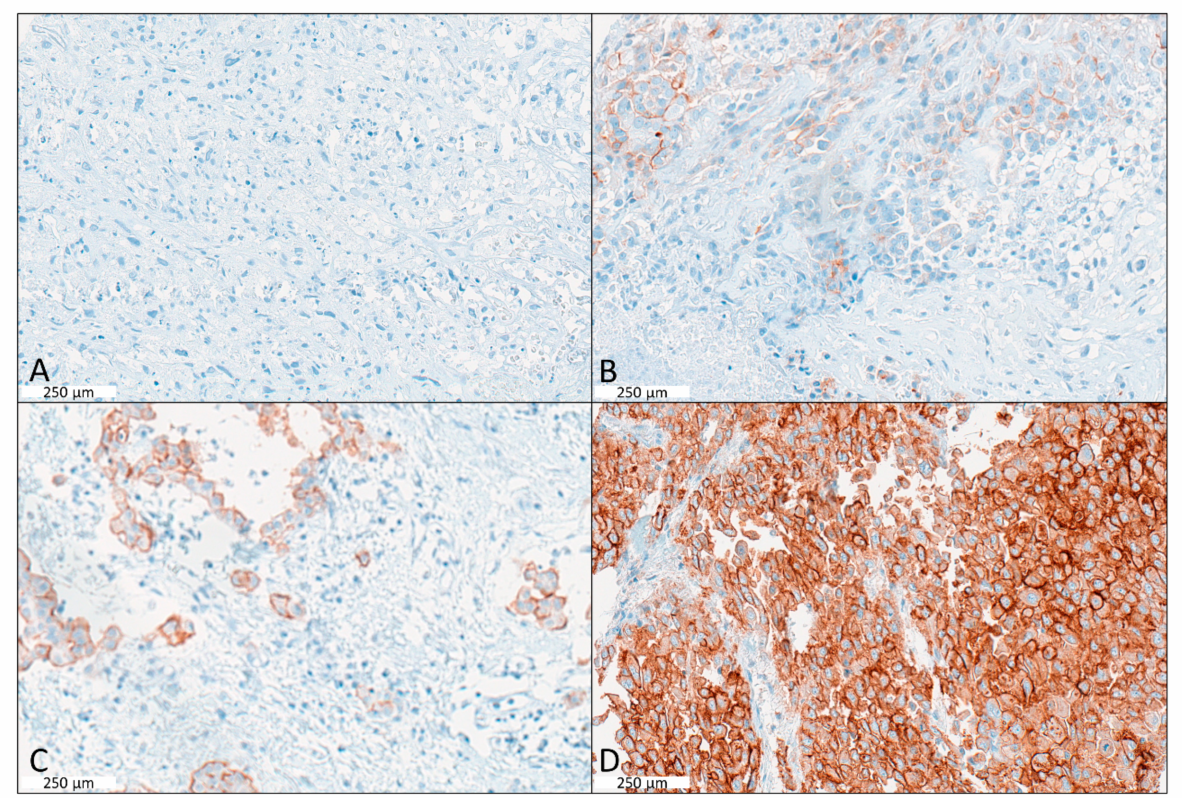
Figure 2. Examples of Immunohistochemically MSLN staining scores. ( A ) IHC of sarcomatoid MPM being negative for MSLN (Score 0). ( B ) IHC of low cytoplasmic expression in epithe- lioid MPM with score 1. ( C ) IHC showing moderate cytoplasmic expression of MSLN (Score 2). ( D ) Immunohistochemically strong cytoplasmic expressing MPM with a score of 3. Scale bar indicates 250 µ m.